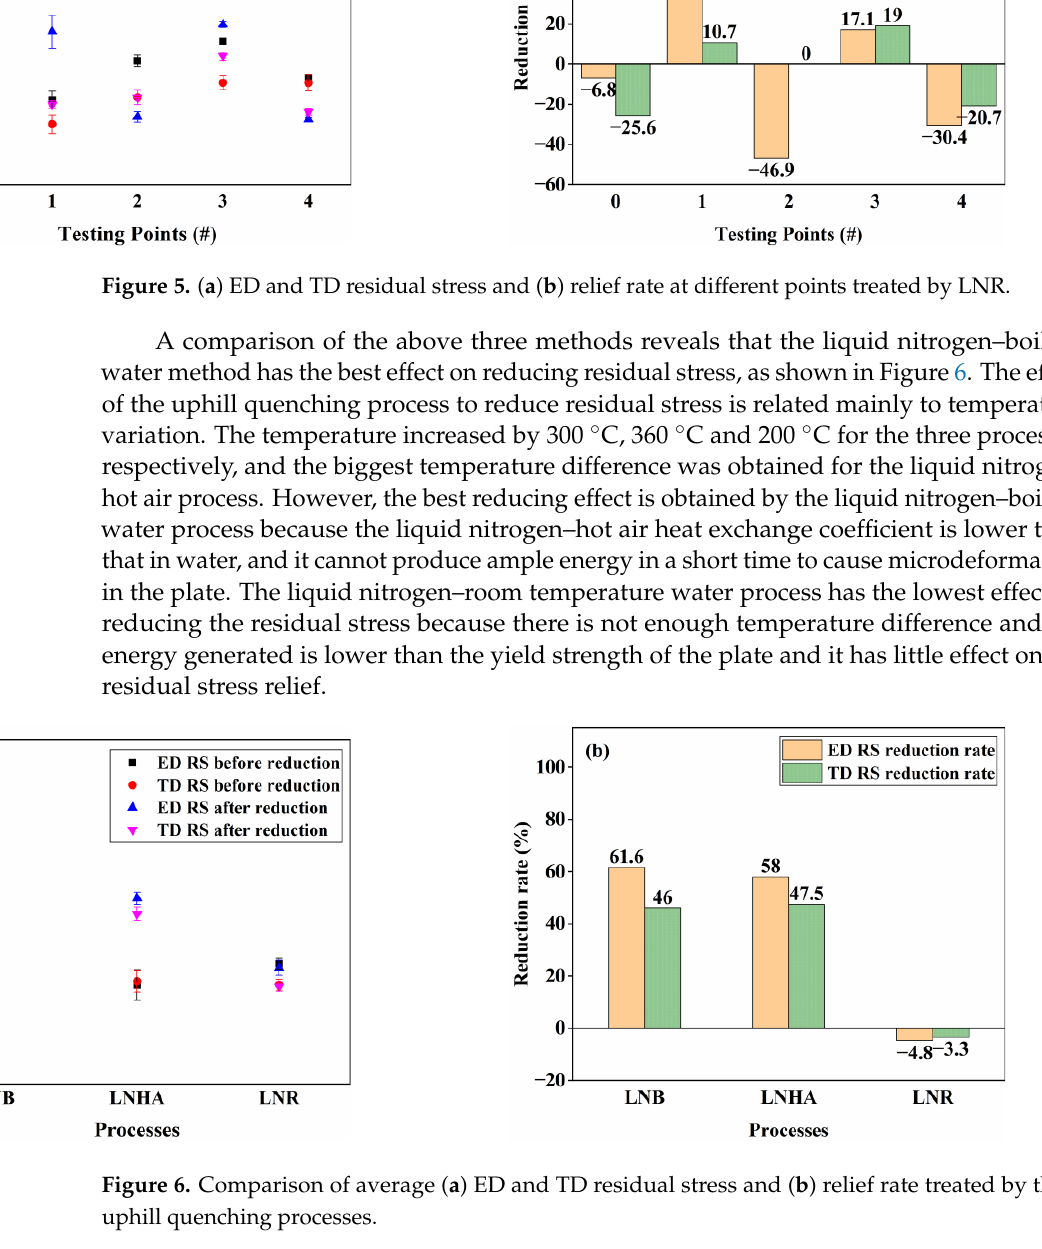
Figure 6. Comparison of average ( a ) ED and TD residual stress and ( b ) relief rate treated by three uphill quenching processes.